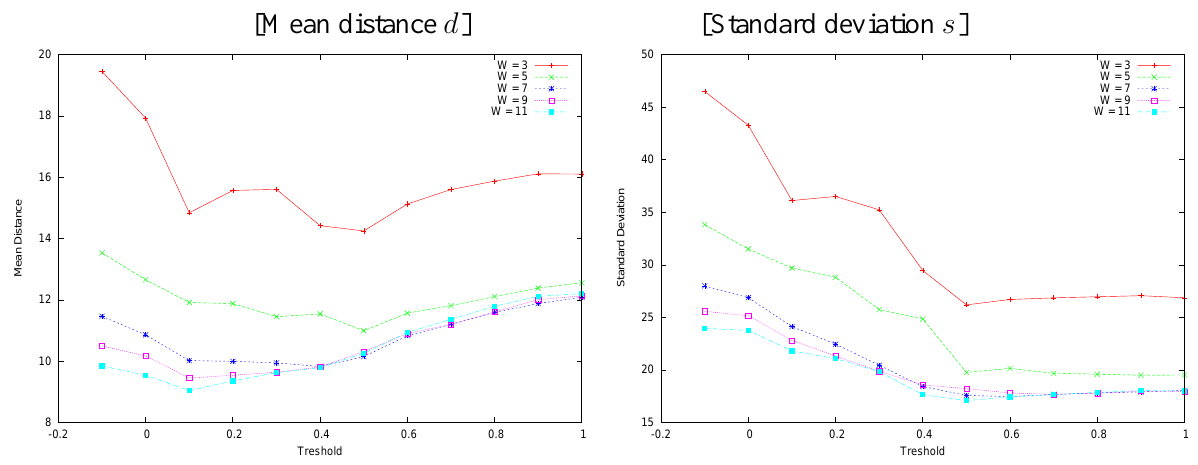
Figure 12. Measured errors for plain correlation with no search interval: Tsukuba pair. [Mean distance d ]